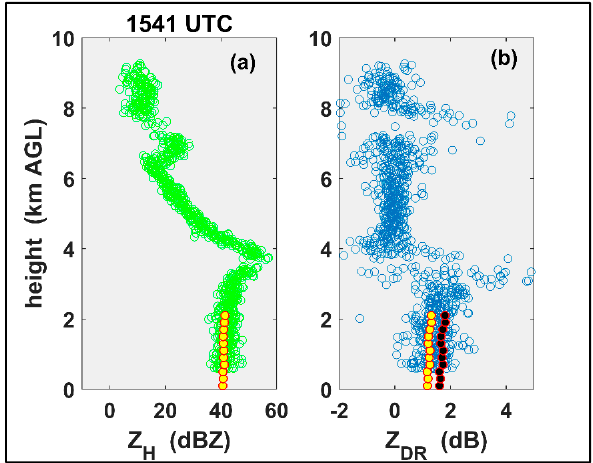
Figure 6. Vertical profiles from NPOL radar RHI scan at 1541 UTC. The scatter of points is due to extracting data from each resolution volume or pixel from 37.5–38.5 km and above 500 m height. The yellow circle markers are forward modelled ( a ) Z H and ( b ) Z DR (assuming σ β = 20° using McSnow control runs in 200 ‐ m layers between 0 and 2 km. The black circle markers are Z DR computed using σ β = 7°.